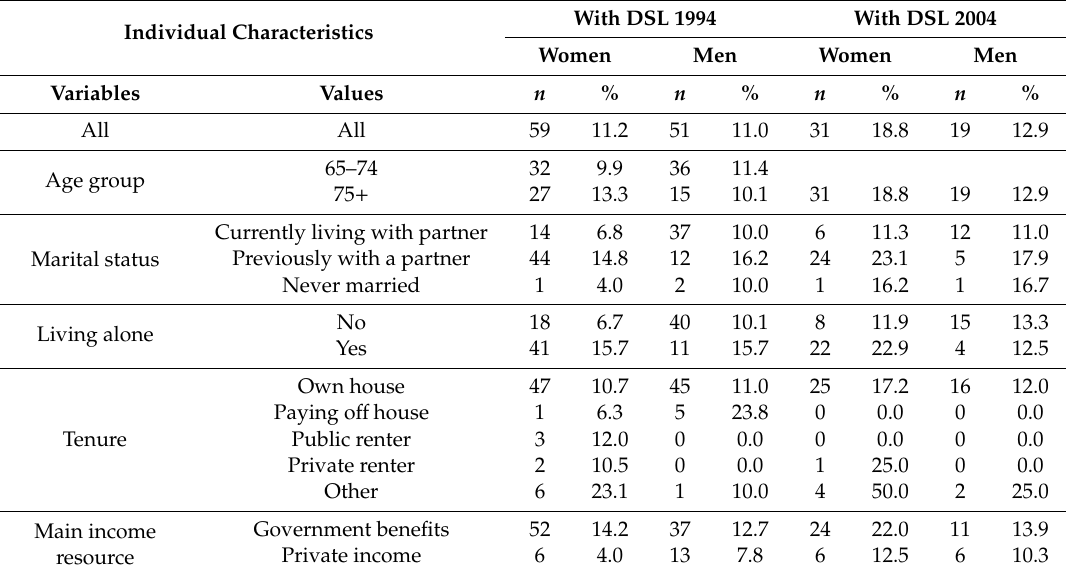
Table 5. DSL by individual characteristics for women and men in 1994 and